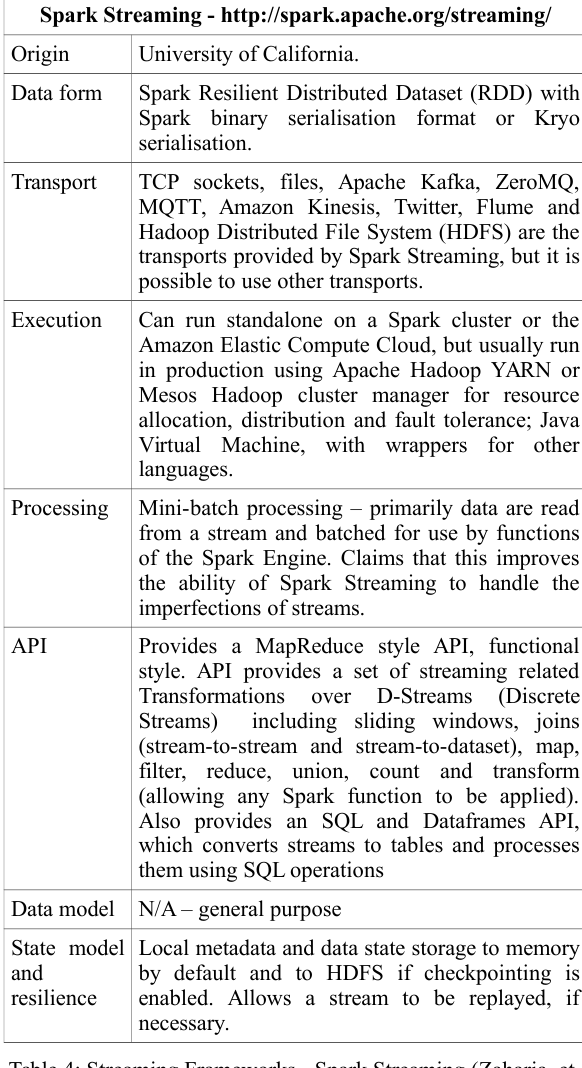
Table 4: Streaming Frameworks - Spark Streaming (Zaharia, et. al.,